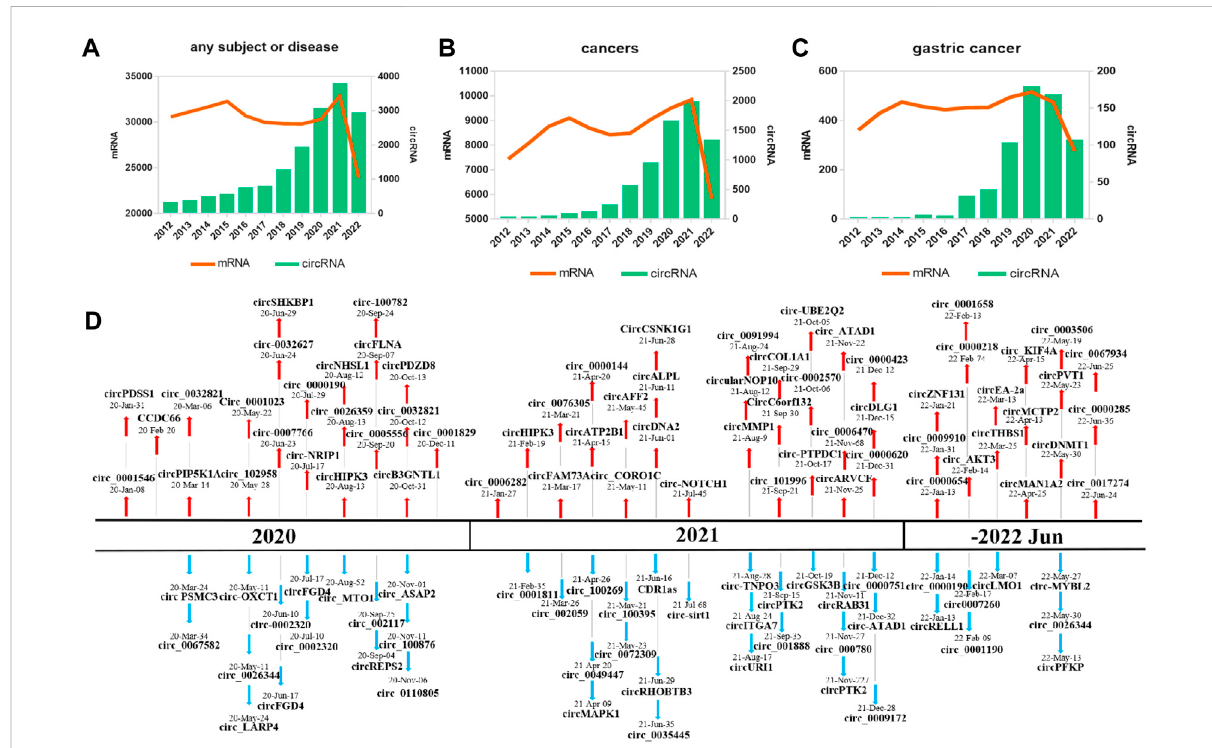
FIGURE 1 Research on and discovery of circRNAs in GC. The amount of research, as quanti fi ed by the annual number of peer-reviewed publications, has beenrelativelystableformRNAs(orangeline)butnotforcircRNAs(bluebars)inthefollowingcategories: (A) anoverall,foranysubjectordisease; (B) cancers; (C) GC. (D) Increasing numbers of novel circRNAs were identi fi ed from 2020 to July